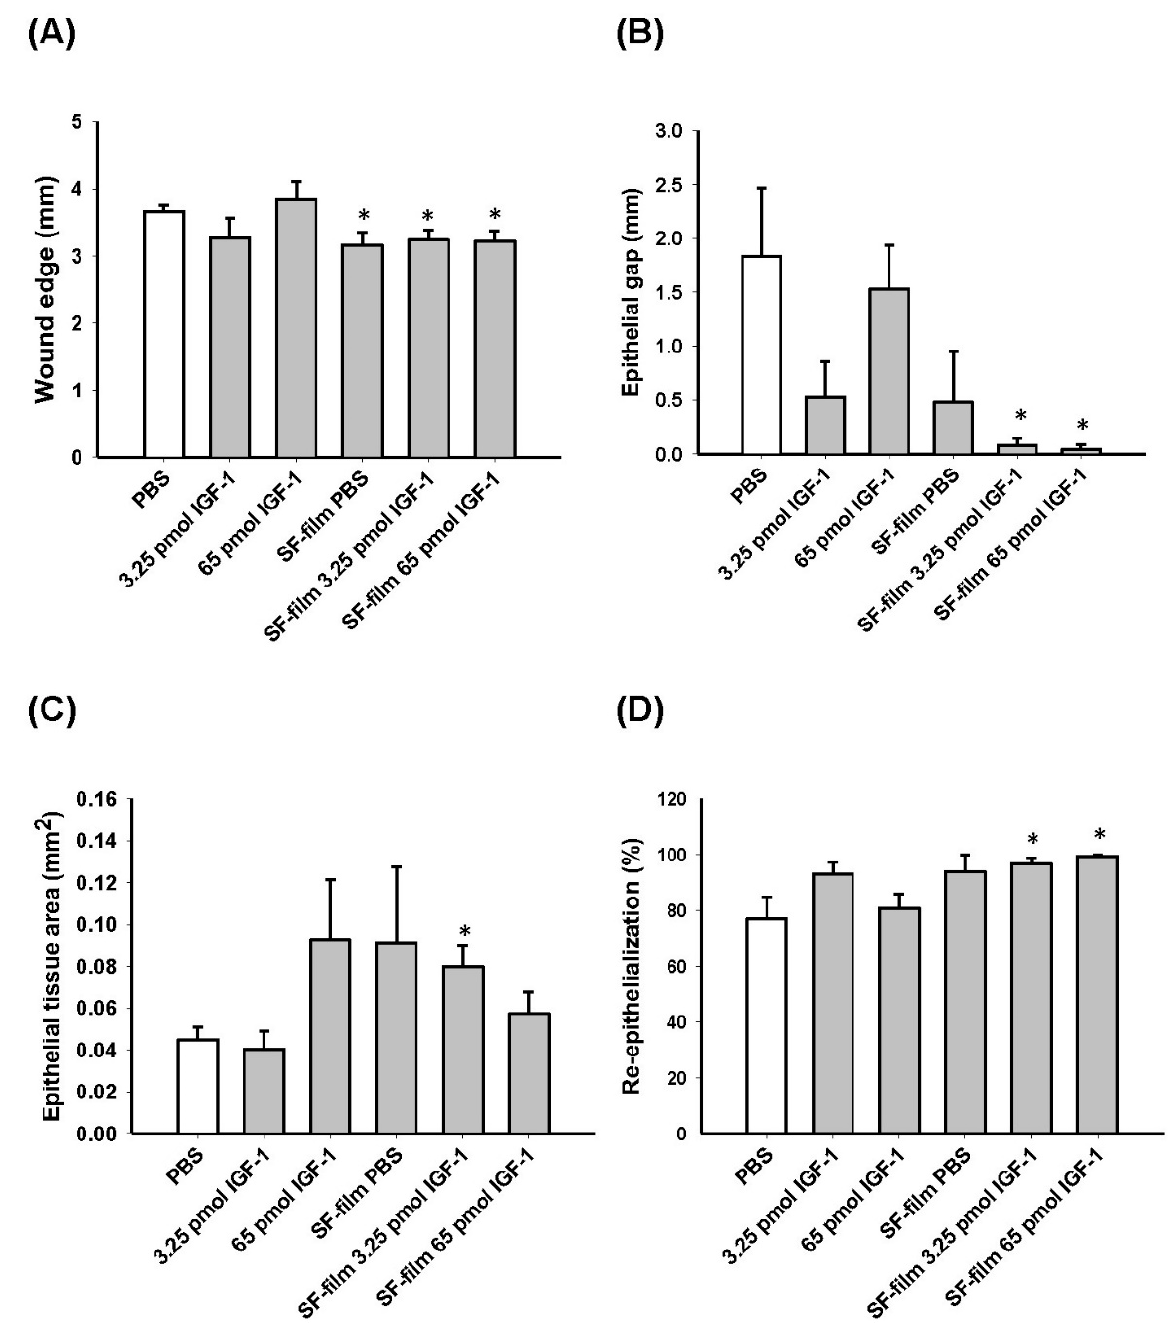
Figure 10. Effects of IGF-1, SF-film, and SF-film–IGF-1 on tissue regeneration in diabetic wounds. Tissues at day 13 post-wounding were histologically analyzed. Quantification of wound-edge distance ( A ), epithelial gap ( B ), epithelial tissue area ( C ), and re-epithelialization ( D ) after wound healing at day 13 post-wounding is shown. Five stained sections from 10 random fields for each group were evaluated and the average diameter was estimated under a light microscope. Significant differences between PBS and each of the treatments were determined statistically by Dunnett’s multiple comparison post hoc test. * p < 0.05; n = 5; all error bars represent the standard error of the mean.